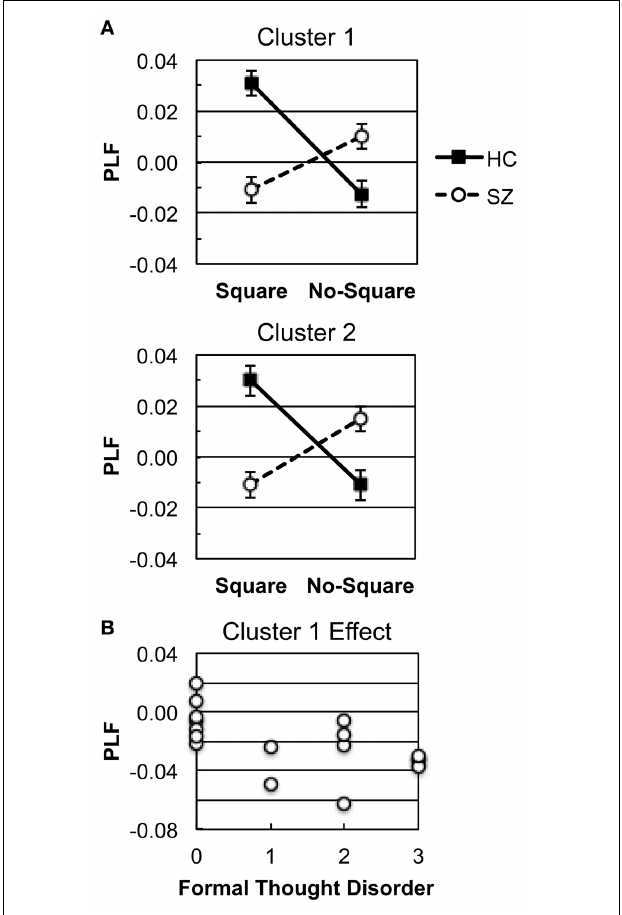
FIGURE 5 | Response-locked γ oscillation effects. (A) Square and No-Square condition PLFs in HC and SZ for each Group X Stimulus cluster (see Figure 4B ). (B) Scatterplot illustrating the correlation between the Cluster 1 effect and the SAPS Global Rating of Formal Thought Disorder scale in